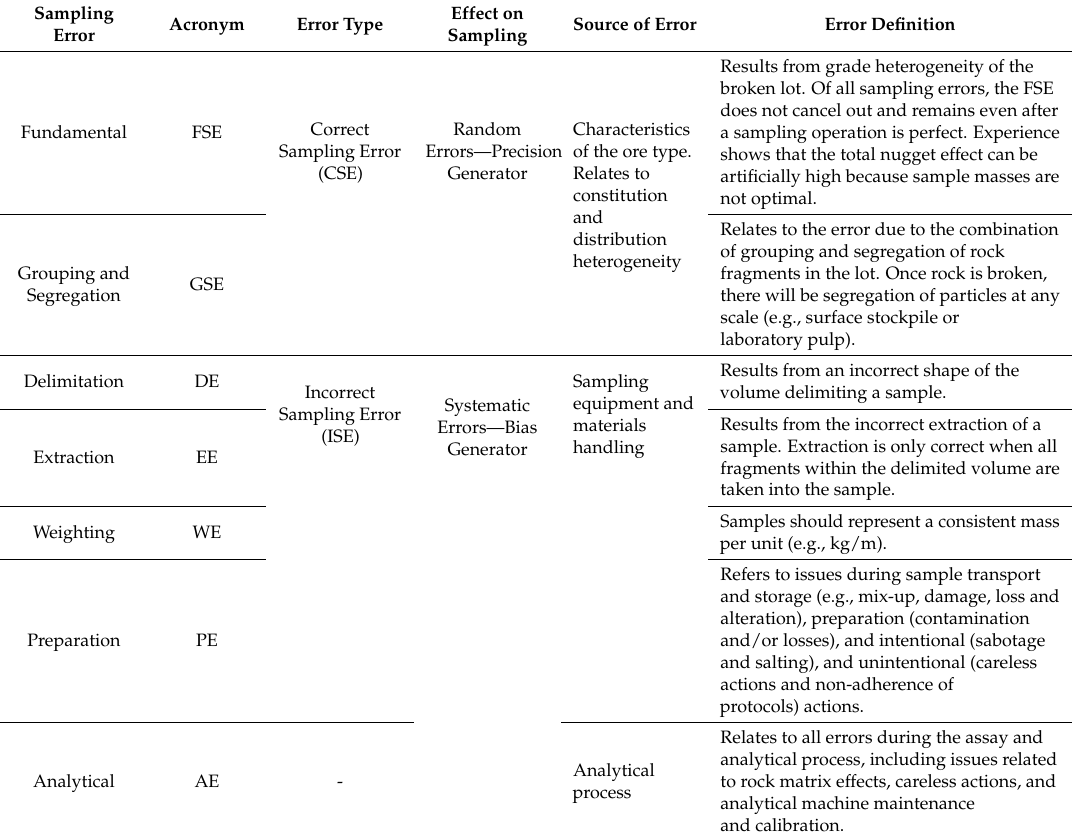
Table 2. Definition of Theory of Sampling (TOS) sampling